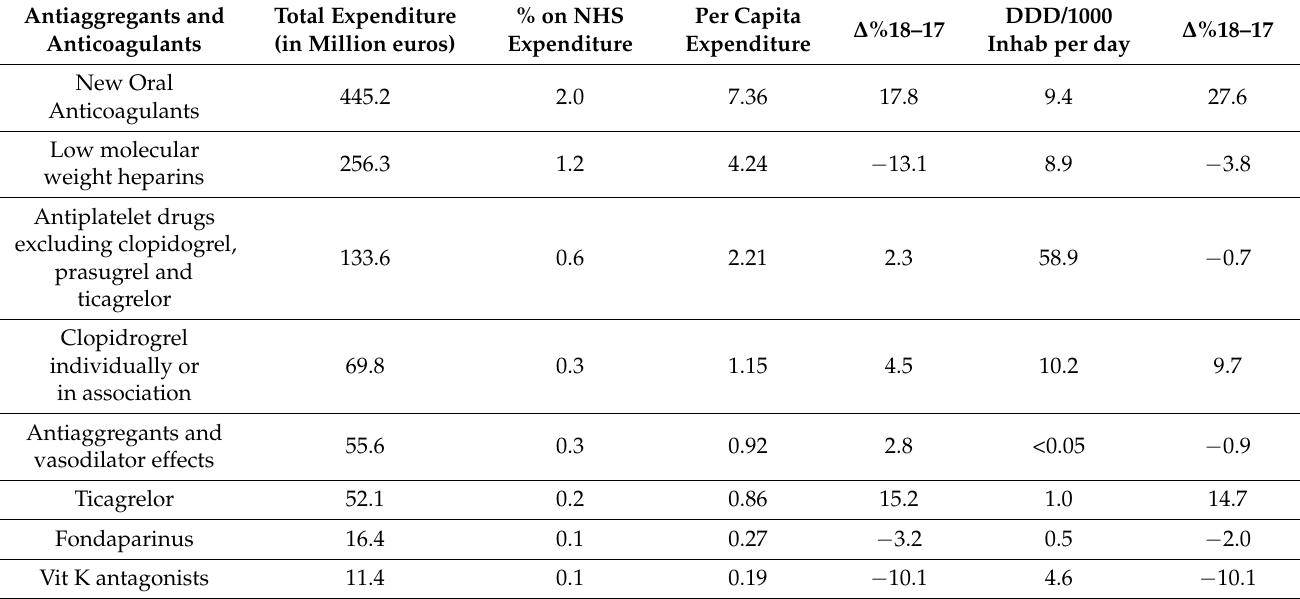
Table 2. Total pharmaceutical expenditure of the antiplatelet agents and anticoagulants’ subgroup for the year 2018 (data from the OSMED 2018